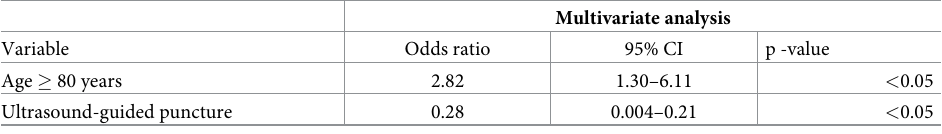
Abbreviation: CI, confidence